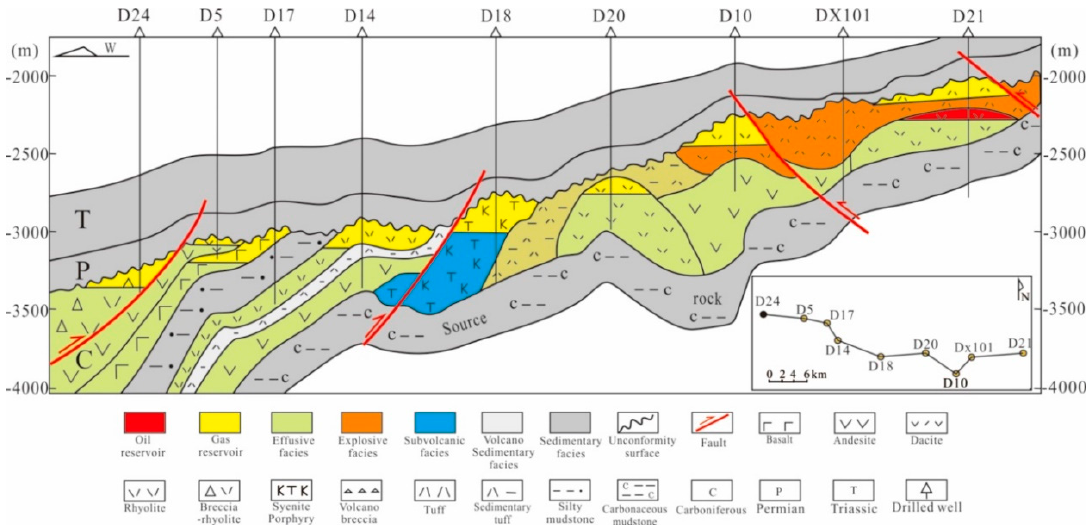
Figure 3. Hydrocarbon-reservoir section of Carboniferous volcanic rocks in the Dixi Area.